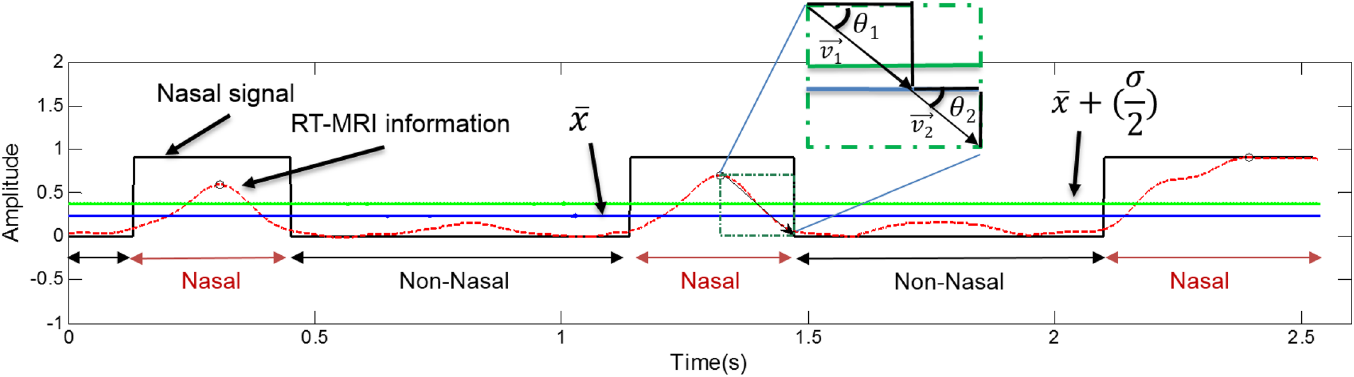
Fig 6. Exemplification of the EMG signal segmentation into nasal and non-nasal zones based on the information extracted from the RT-RMI (dashed red line). The square wave depicted with a black line represents the velum information split into two classes where 0 stands for non-nasal and 1 for nasal. The blue line is the average of the RT-MRI information (after normalization) and the green line is the average plus half of the standard deviation.